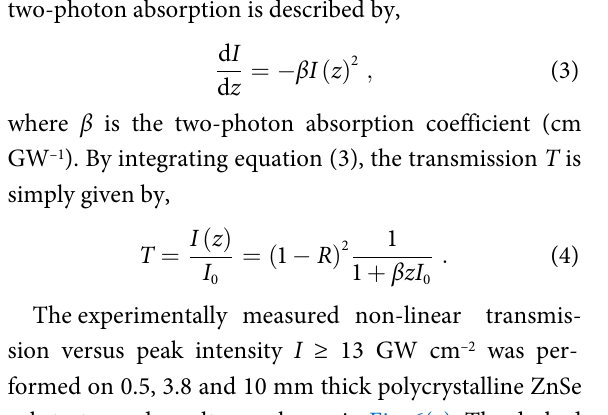
Fig. 6 | ( a ) The transmission of 0.5, 3.8 and 10 mm polycrystalline ZnSe at τ = 200 fs pulse length as a function of the incident peak in- tensity. The excellent fit (red dashed line) to the data for 0.5 mm sample includes the measured variation of β from Z scans. The non- linear response is due to two-photon absorption and higher order. The solid lines represent the best fit to the data for thicker samples. ( b ) The transmission of 3.8 mm polycrystalline ZnSe at peak intens- ity below 5 GW cm –2 and fit to equation 4 with β = 3.5 cm GW –1